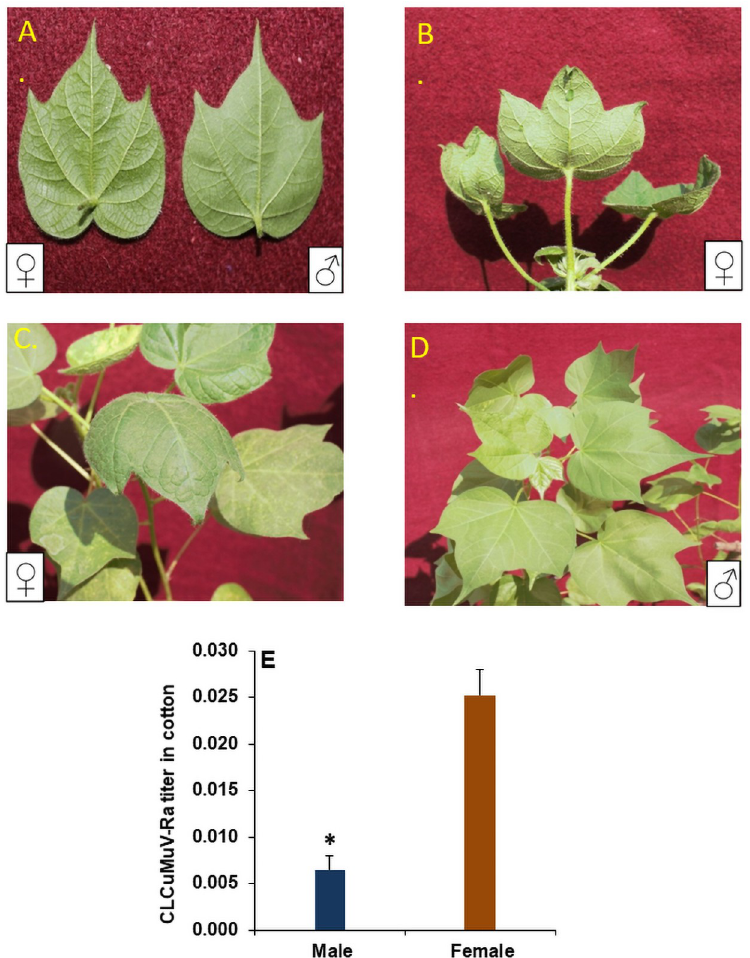
Fig 2. A. Early vein thickening in cotton plant after inoculation with viruliferous male and female whiteflies; B. Typical curling and enation in cotton after infection with viruliferous females; C. Downward curling in cotton plant after inoculating with viruliferous females; D. Symptomless or delayed symptoms in cotton plants after infection with viruliferous male; E. Relative amount of Cotton leaf curl Multan virus -Rajasthanin host plant normalized with histone 3 as housekeeping gene for G . hirsutum . The error bars represent the standard deviation (n = 3) and � represents significant differences (P � 0.05, Student’s t-test).